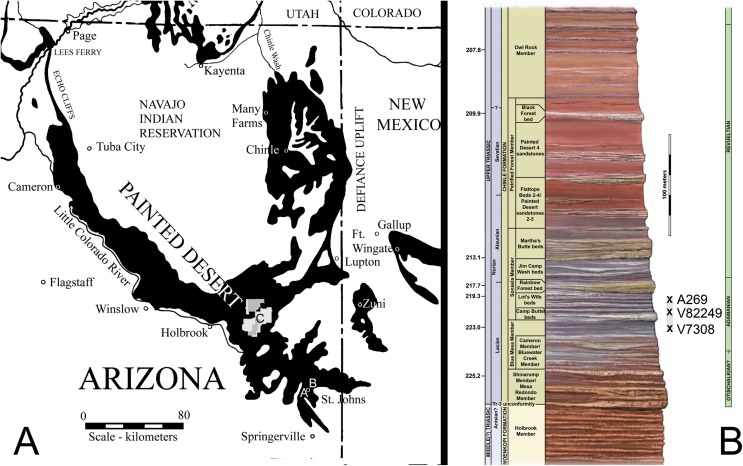
Locality map and stratigraphic section.(A) Map of Chinle Formation localities in northeastern Arizona; A. Placerias Quarry; B. Blue Hills; C. Petrified Forest National Park. (B) Stratigraphic section of the Chinle Formation near Petrified Forest National Park, showing the position of the localities from (A) and the stratigraphic range of Calyptosuchus wellesi. Stratigraphy from Martz et al. (2012). Radioisotopic dates from Ramezani et al. (2011). Relative position of locality V7308 from J. W. Martz & W.G. Parker (2008, unpublished data). Position of V82249 from Parker & Martz (2011). Position of A269 based on geochronological correlation using data from Ramezani, Fastovsky & Bowring (2014).